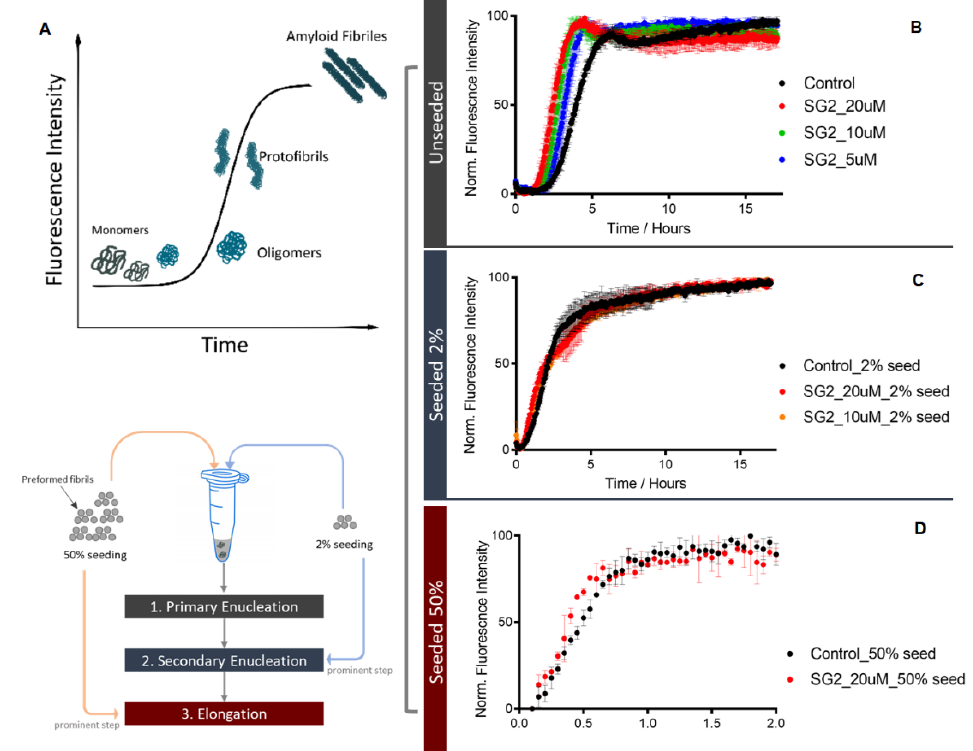
Figure 2. SG2 does not directly inhibit A β 42 aggregation in in vitro assays. The aggregation of 2 µM A β 42 was performed in 20 mM sodium phosphate buffer with 0.2 mM EDTA at pH 8. The amyloid-specific dye thioflavin T (ThT) at 20 µM was used as a fluorescence probe to monitor the progression of the aggregation process as depicted in panel ( A ). SG2 was added to A β 42 at different concentrations in presence or in absence of preformed fibrils (seeds), as shown in each panel. In the seeded assays, 2% or 50% of preformed fibrils were added to the solution before the start of the aggregation process. Varying the seeds concentration in the assay solution allows to monitor different steps of the A β 42 aggregation process. Results are presented as normalized fluorescence intensity, which is indicative of the A β 42 formation, over time. SG2 has a slight effect on primary enucleation (unseeded assay, panel B ), while does not affect the secondary enucleation (panel C ) or the elongation step (panel D ).